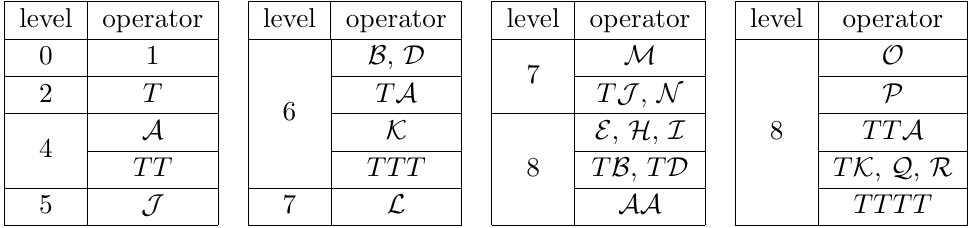
Table 2 . To level 8, the CFT n holomorphic quasiprimary operators. We have omitted the replica indices and their constraints. The de(cid:12)nitions of J , K , L , M , N , O , P , Q , R can be found in [54], and the normalization factors (cid:11) K and OPE coe(cid:14)cients d K for all these quasiprimary operators can also be found therein.